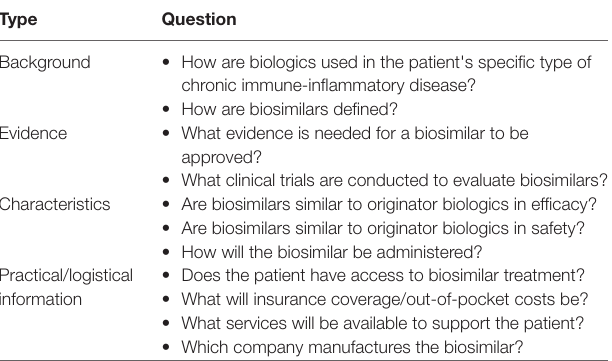
TABLE 2 | Questions about biologic/biosimilar therapy for healthcare professionals to answer when discussing biosimilar use with patients (Jacobs et al.,